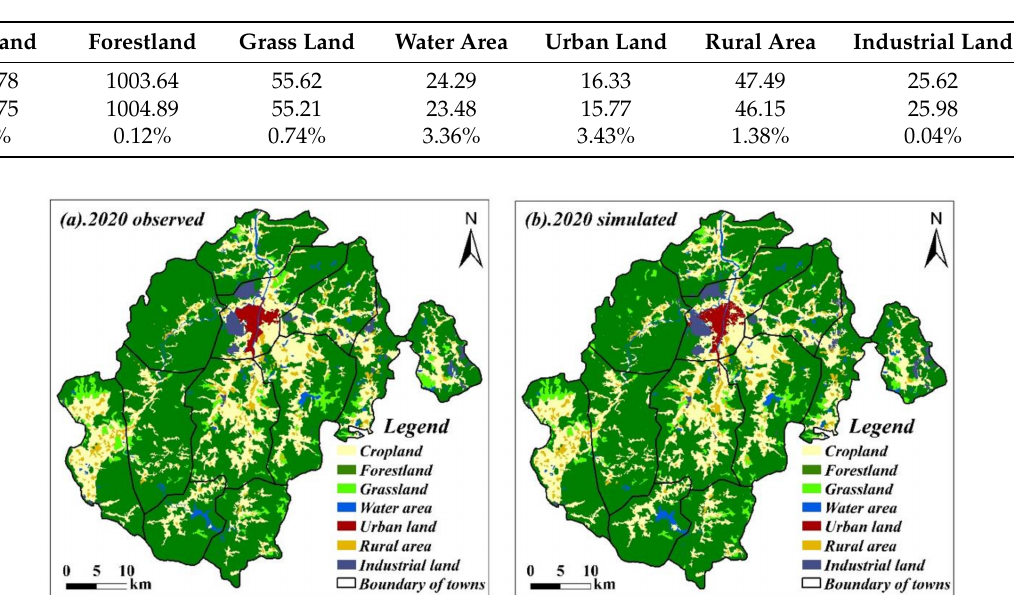
Table 3. Comparison between projected areas and actual areas of 2020 (km 2 ).